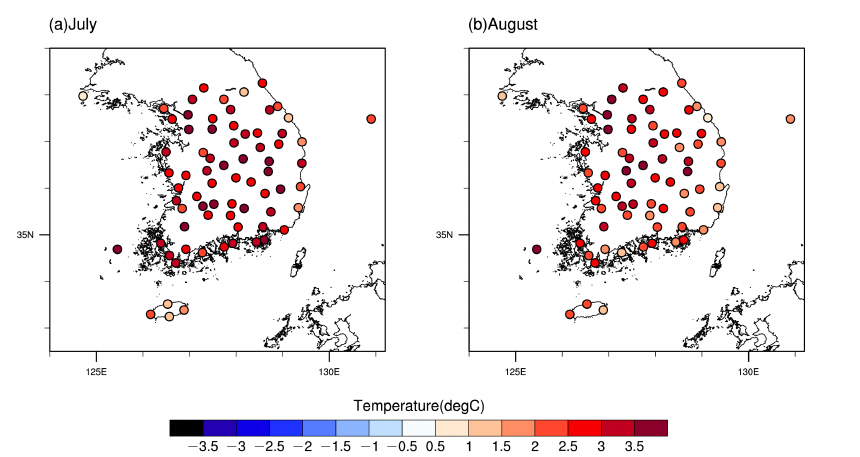
Figure 3. The monthly temperature anomaly in July and August 2018 against the climatology from 1981 to 2010. Each circle over the map indicates the KMA observation stations (ASOS); the color means the difference between monthly temperature and climatology.